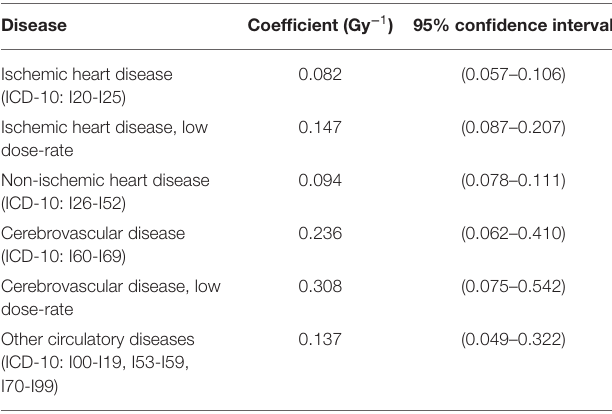
TABLE 2 | Excess relative risk coefficients for CVD (7).